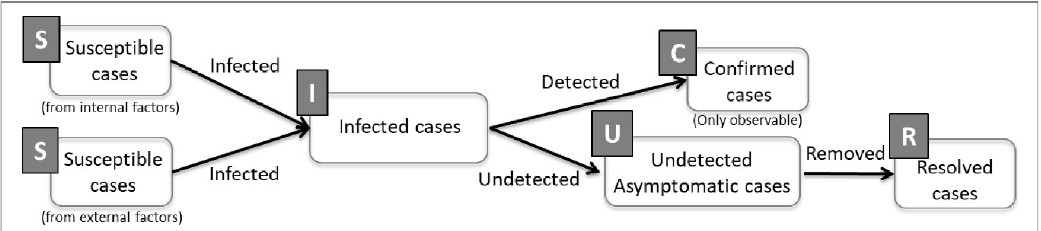
Fig 1. Structure map of the SICUR